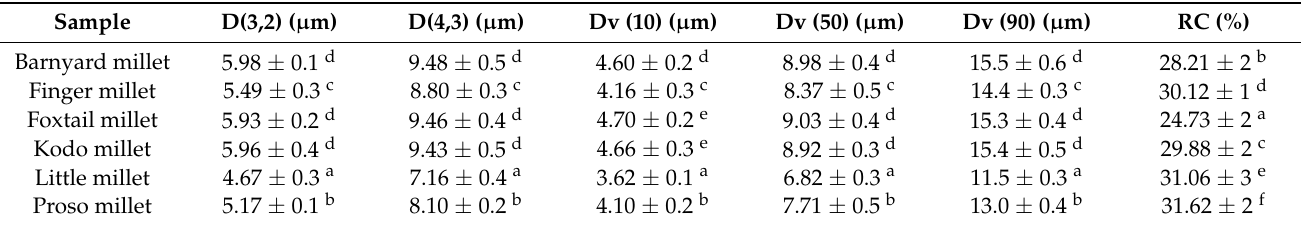
Table 3. Particle size distribution and relative crystallinity of millet